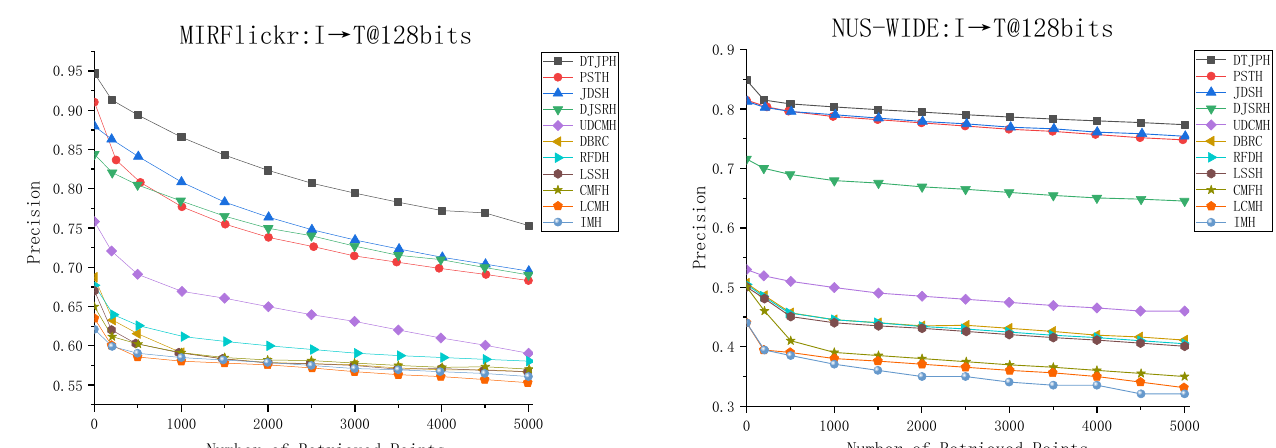
Figure 4. The top-N precision curves of an image retrieving text. The length of binary feature vectors is 128.